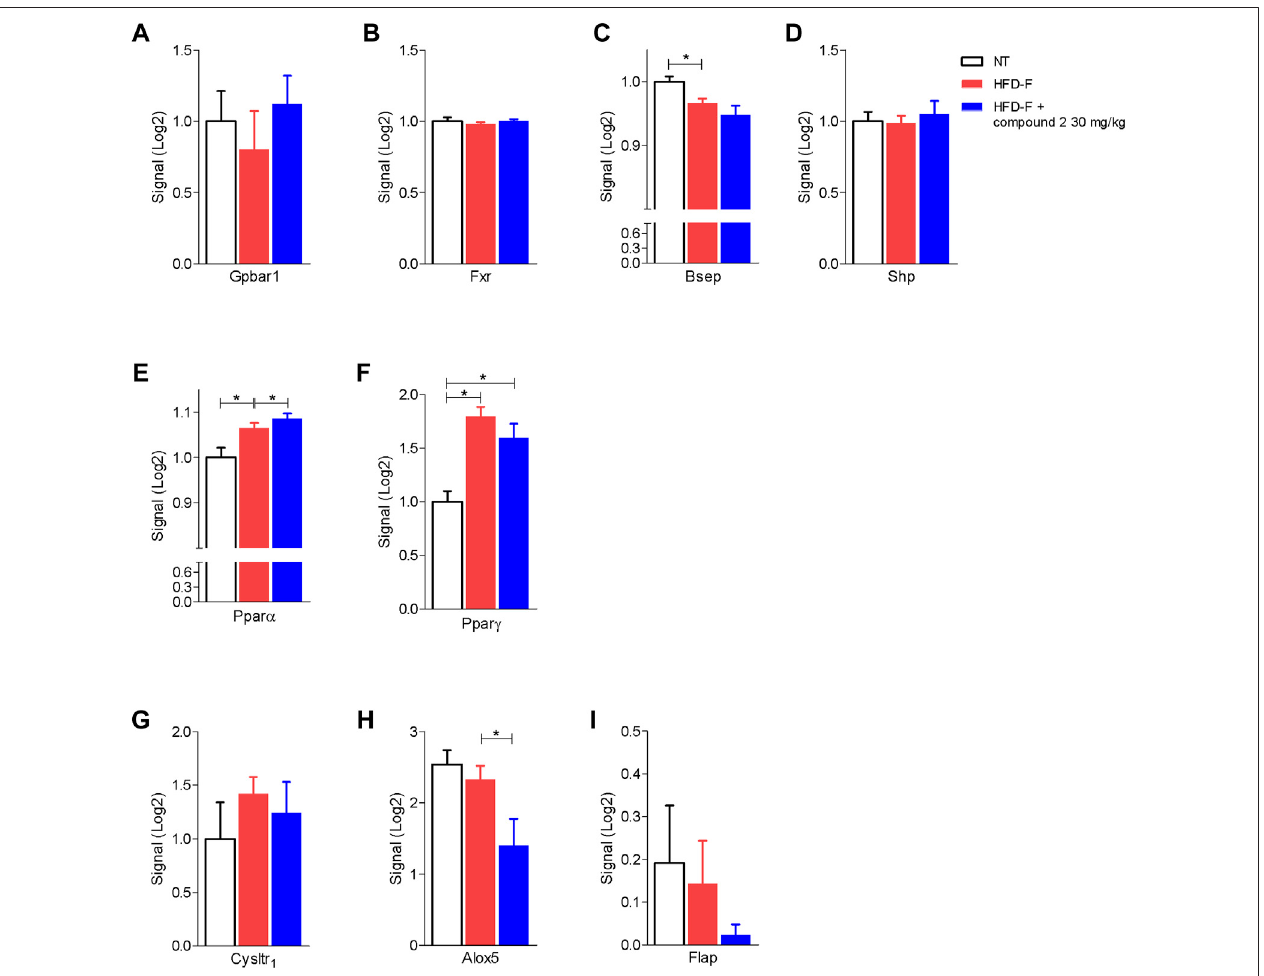
FIGURE8| Effectsofcompound2onliverexpressionofGPBAR1,FXR,anditstargetgenesandnucleartranscriptionfactors.C57BL/6malemicewerefedahigh fat diet and fructose (HFD-F) or normal chow diet for 61 days. From day 7 compound 2 was administered by oral gavage at the dose of 30 mg/kg/daily. Relative mRNA expression levels extract from RNA-seq analysis of: (A) Gpbar1, (B) Fxr, (C) Bsep, (D) Shp, (E) Ppar α , (F) Ppar γ , (G) CysLT 1 R, (H) Alox5, and (I) Flap. Results are the mean ± SEM of 5-7 mice per group; * p < 0.05.